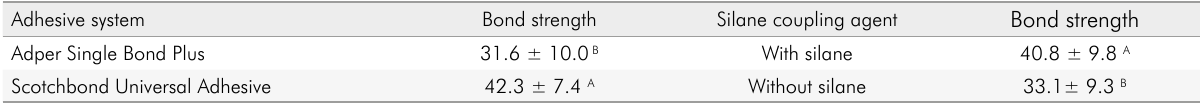
Table 3. The microtensile bond strength means (MPa) and respective standard deviations considering the main factors Adhesive